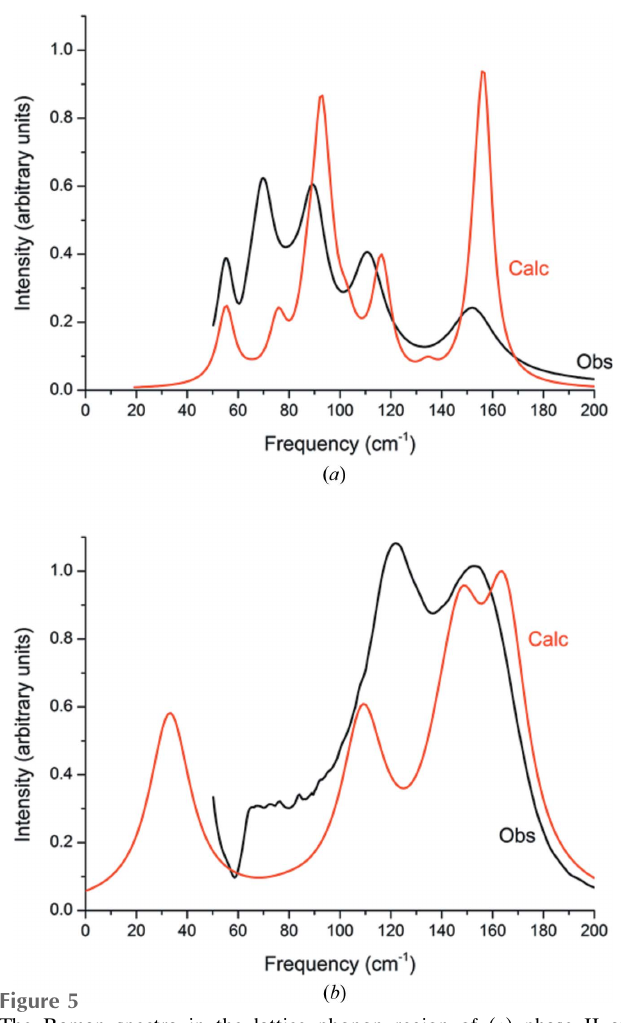
Figure 5 The Raman spectra in the lattice phonon region of ( a ) phase II at 1.09 GPa and ( b ) phase III at 1.69 GPa, collected in the same regions as the diffraction data. Observed data – black; DFT-calculated data – red.